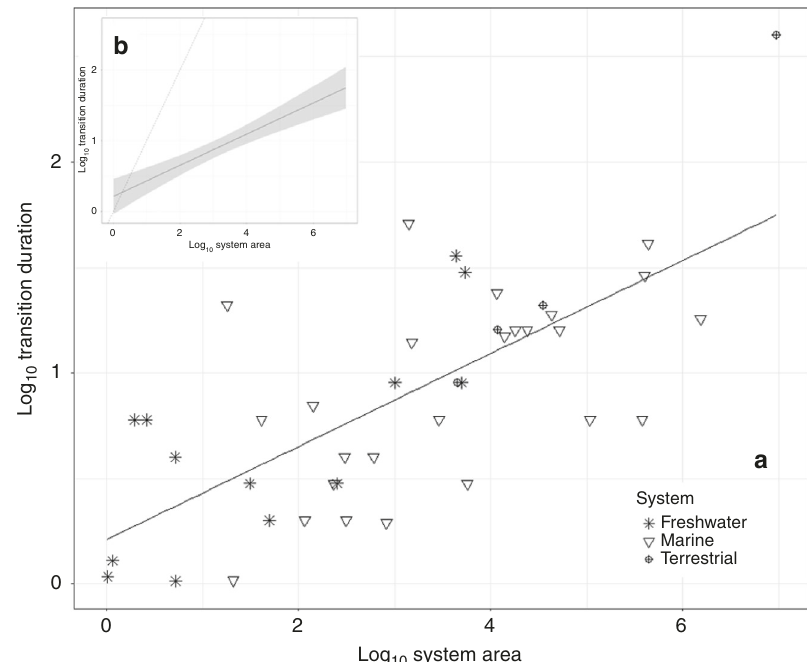
Fig. 2 Empirical relationship between system area and regime shift duration. a The log – log linear relationship between the spatial area and the temporal duration of 42 observed Earth system regime shifts is described by a linear regression model (solid line: R 2 = 0.491, p < 0.001, df = 40). This illustrates the positive and sub-linear (slope = 0.221) association between system size and shift duration. b The relationship in A is compared with the 1:1 reference line (dashed line, slope = 1). The untransformed unit of the x -axis is kilometres-squared, while the y -axis is years. The shading represents the 95% con fi dence interval around the regression model; see Supplementary Table 1 for individual case-study details and see Supplementary Fig. 4 for the regression models grouped by system